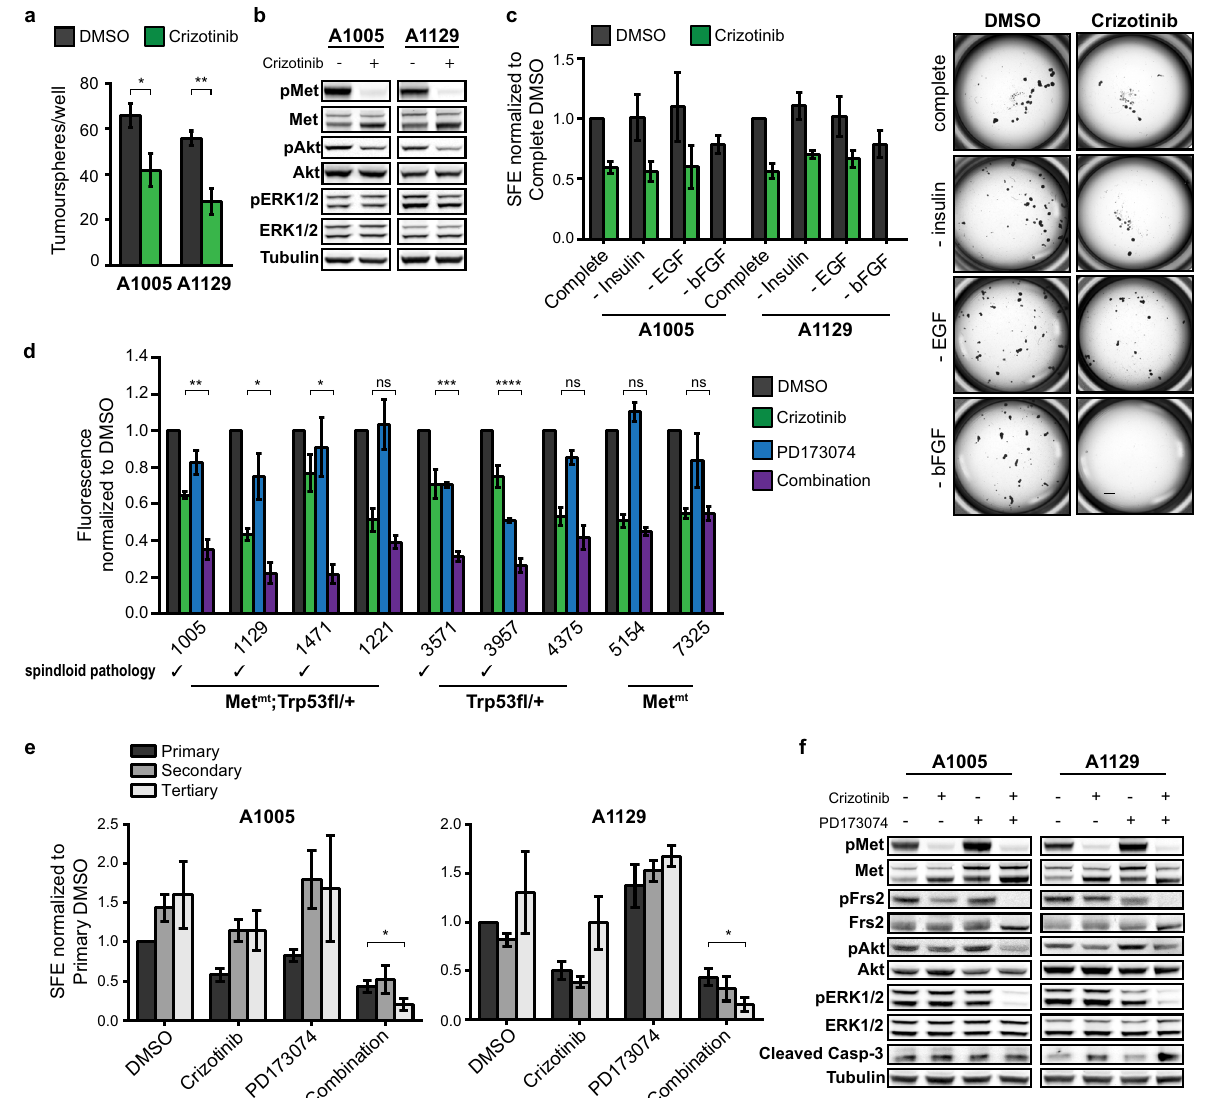
Fig. 2 Dual inhibition of Met and FGFR signalling abrogates tumoursphere formation of spindloid tumour cells in vitro. a A1005 and A1129 tumourspheres were cultured in the presence or absence of Crizotinib (1 μ M) and counted after 5 days ( n = 3). b The activation of Met and its downstream signalling effectors in control and Crizotinib-treated tumourspheres were assessed by western blot analysis ( n = 3). c A1005 and A1129 tumourspheres were cultured in media lacking insulin, EGF (20 ng/ml), or bFGF (20 ng/ml), and in the presence or absence of Crizotinib (left). Representative images of tumourspheres in growth factor-depleted media are shown (right) ( n = 3). Scale bar: 500 μ m. d A panel of MMTV- Met mt ;Trp53 fl / + ; Cre , and MMTV- Met mt cells were seeded in 96-well low-attachment plates, treated with 1 μ M Crizotinib and/or 1 μ M PD173074, and tumoursphere proliferation was detected by Cyquant proliferation assay (Invitrogen) ( n = 3). e A1005 and A1129 tumourspheres were allowed to form over 48 h, and subsequently treated with Crizotinib and/or PD173074 for 72 h. Primary tumourspheres were enzymatically and mechanically dissociated into single cells and serially passaged to assess self-renewal capacity ( n = 3). f Western blot analysis was used to detect cell death and signalling changes in tumourspheres treated with Crizotinib and/or PD173074 for 72 h ( n = 3). Student ’ s t test; * P ≤ 0.05; ** P ≤ 0.01; *** P ≤ 0.001; **** P ≤ 0.0001. Error bars indicate Frs2 scaffold protein is required downstream of FGFR1 for maintenance of TIC capacity of spindloid MMTV- Met mt ;Trp53 fl / + ; Cre in the absence of Met activation.